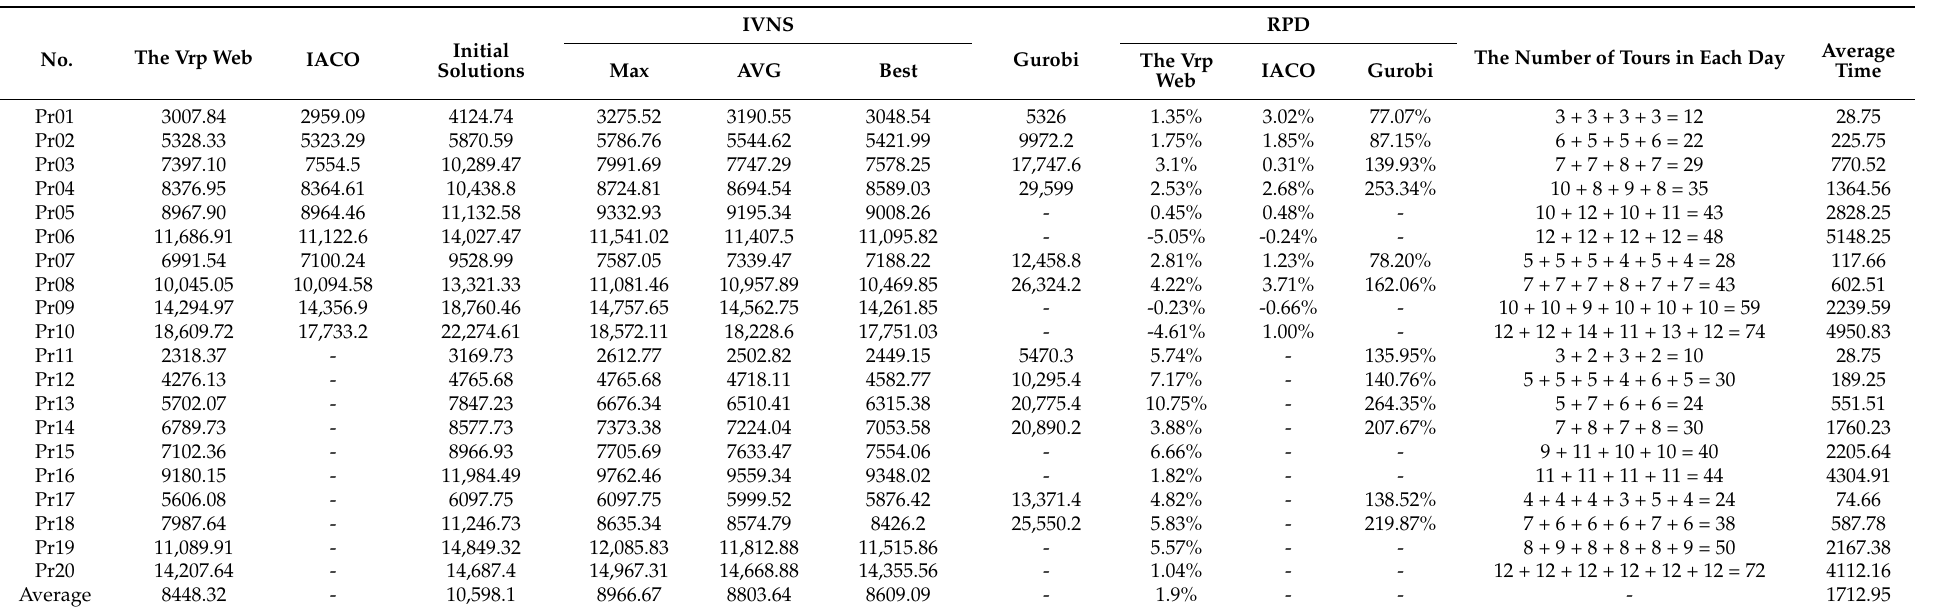
Table 4. Results of PVRPTW